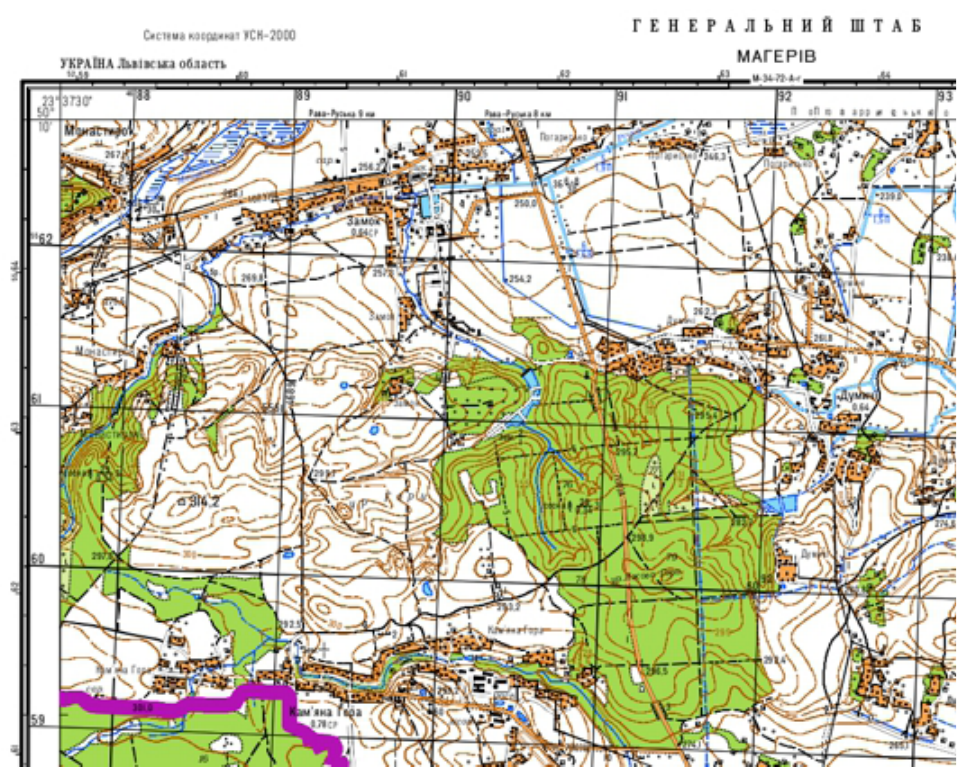
Fig. 2. A part of the nationwide 1:50,000 scale topographic